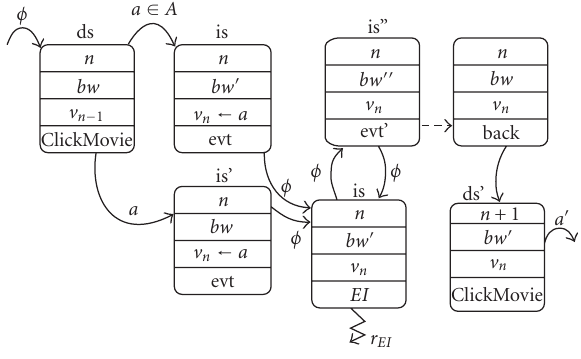
Figure 6: MDP dynamics